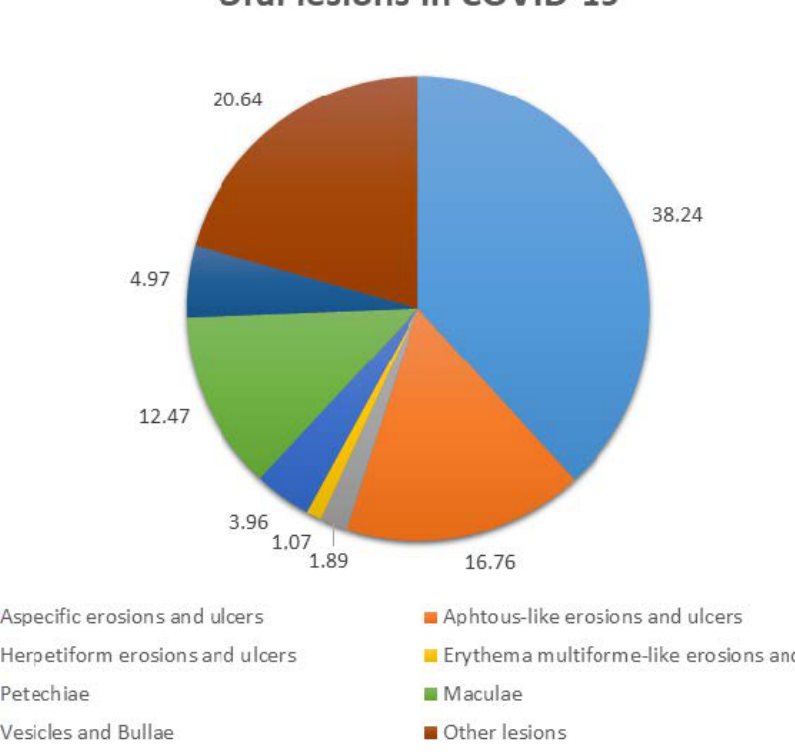
Figure 2. Reported frequency of oral lesions in